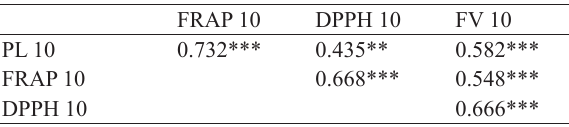
Table 2 Single correlation coefficients between chosen features of